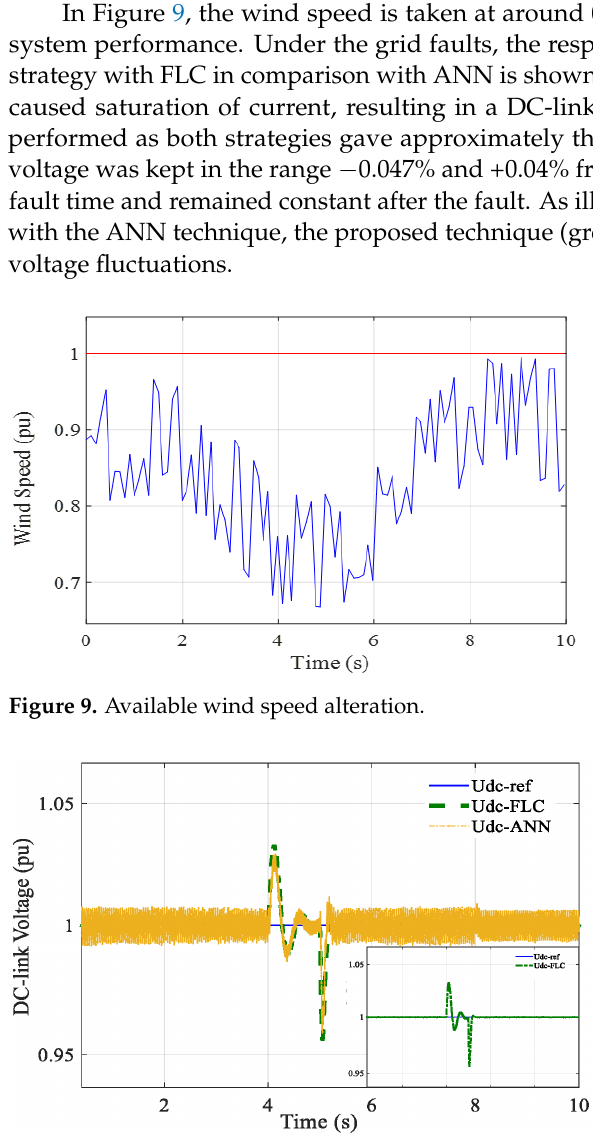
Figure 10. The DC-link voltage